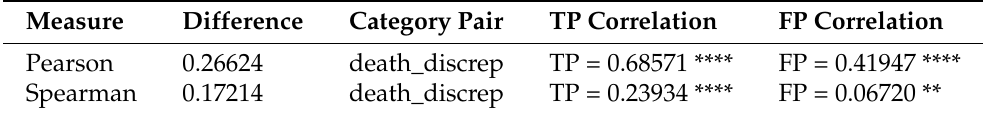
Table 32. Death and Discrepancy in Medium.